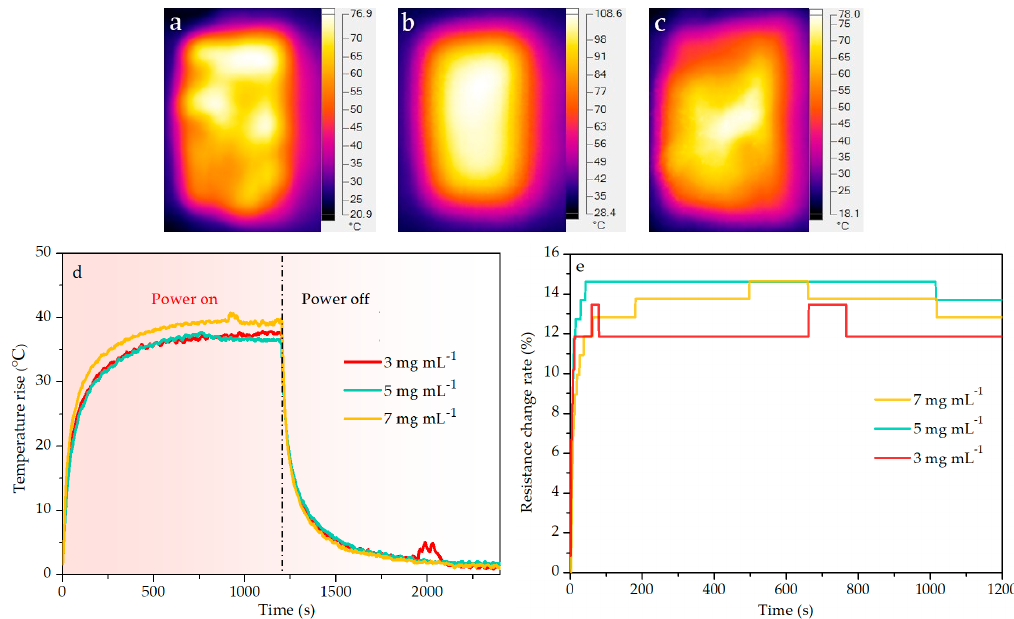
Figure 9. Infrared thermogram of the electrothermal CCGA: ( a ) 3–CCGA, ( b ) 5–CCGA, ( c ) 7–CCGA; ( d ) time–temperature rise curve of different electrothermal CCGA; ( e ) resistance change rate and time relationship during the electrification for 20 min under the power density of 2000 W m –2 .